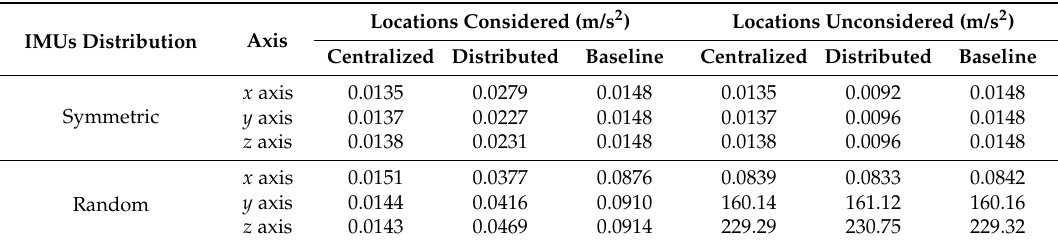
Table 2. Standard deviation of the acceleration estimation errors, for the symmetric and random 27 IMUs configurations within the 200 mm edges cube.